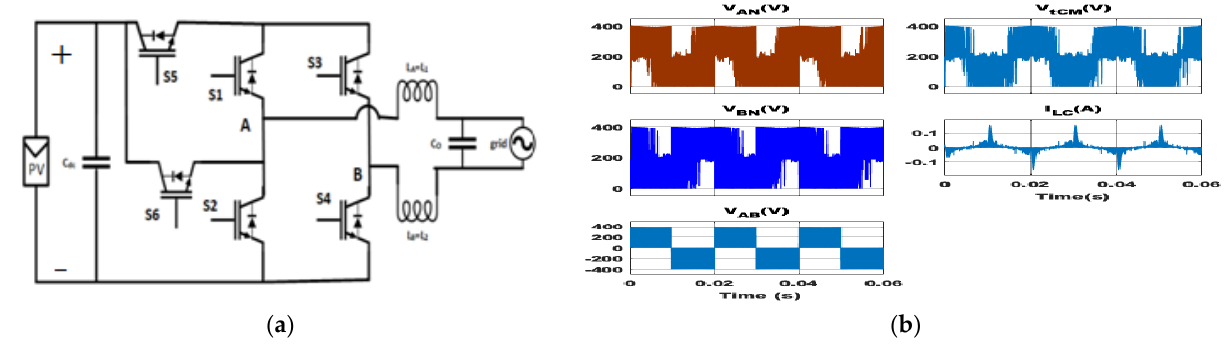
Figure 9. Modified H6 topology: ( a ) circuit structure; ( b ) simulation results.